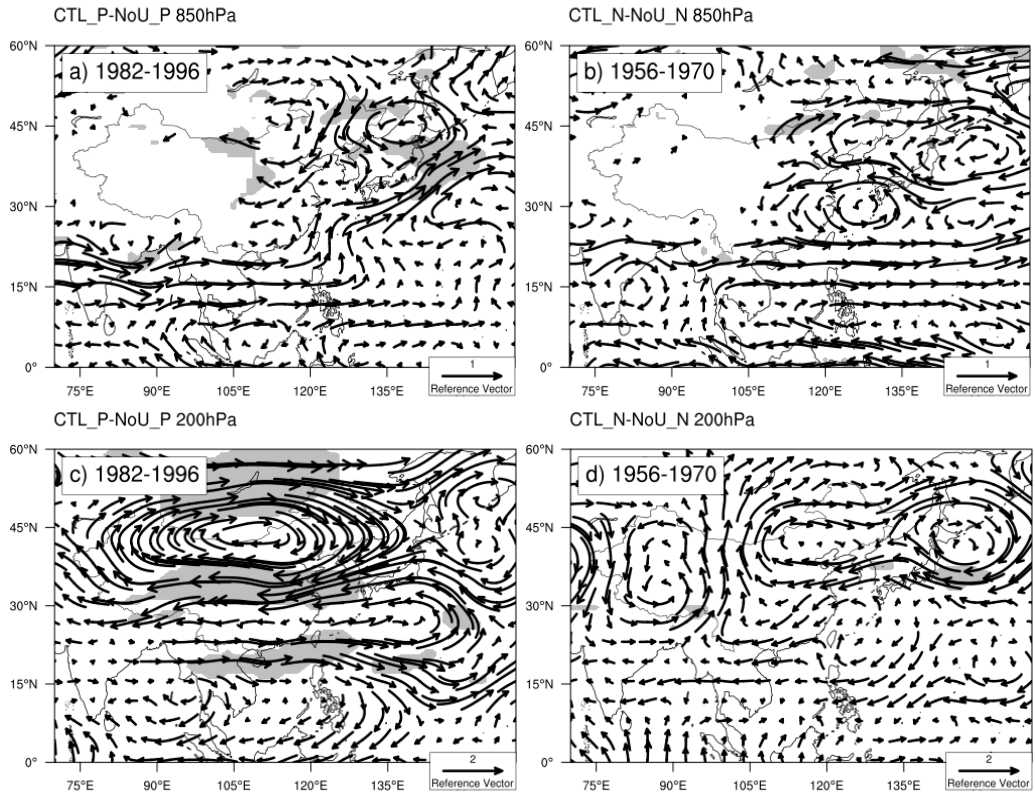
Figure 5. Difference fields (CTL_P minus NoU_P and CTL_N minus NoU_N) of wind vectors on 850 hPa ( a , b ; units: m/s) and 200 hPa ( c , d ; units: m/s). ( a , b ) use the SST of 1982–1996, and ( c , d ) use the SST of 1956–1970. Above 90% confidence level of wind speed has been shaded.